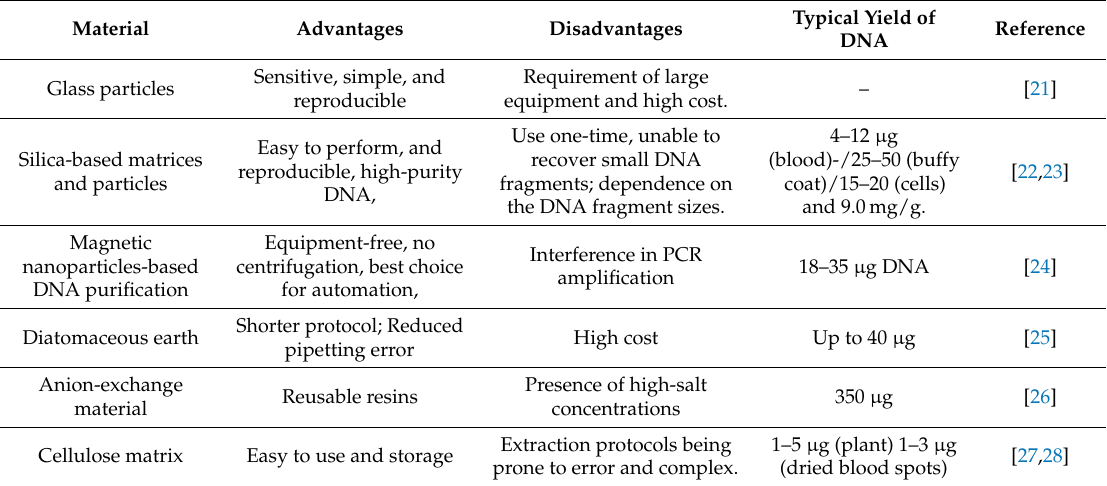
Table 1. Comparison of different adsorbent materials along with their advantages and